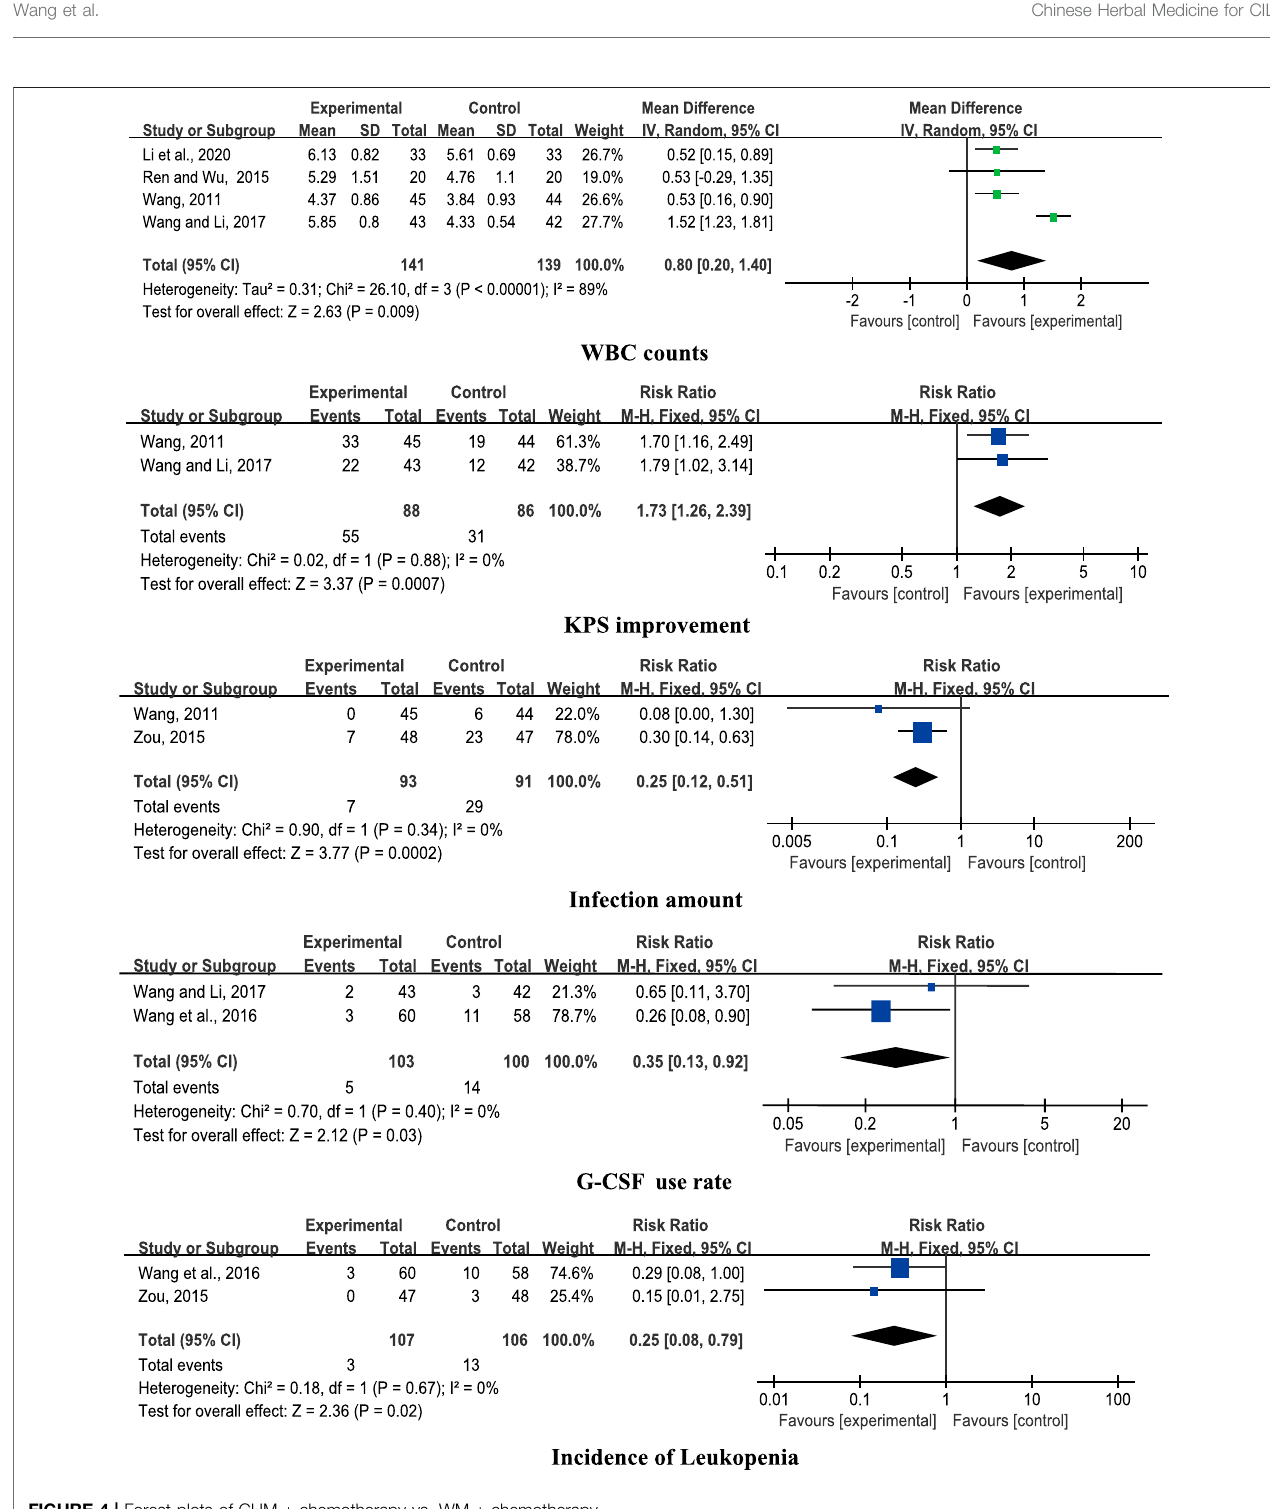
Frontiers in Pharmacology |